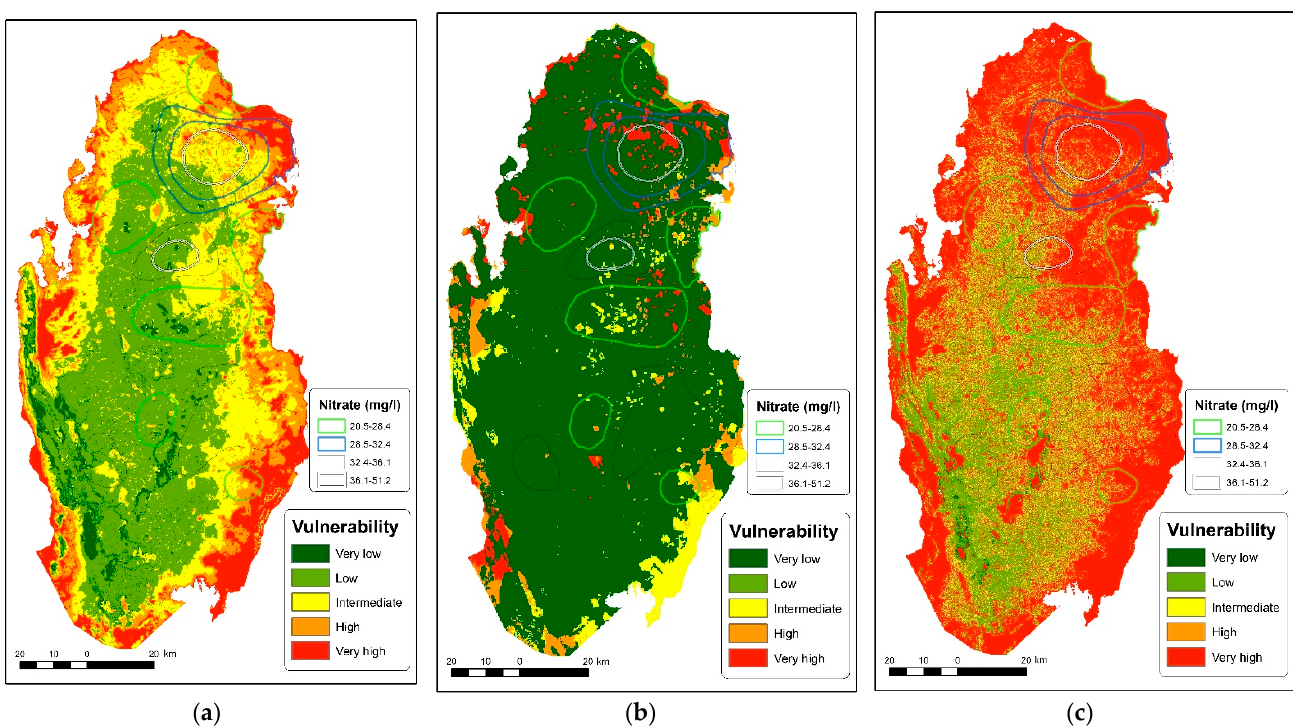
Figure 9. Nitrate concentration over DRASTIC model ( a ), FL–Gamma = 0.99 ( b ), and FL Sum ( c ).